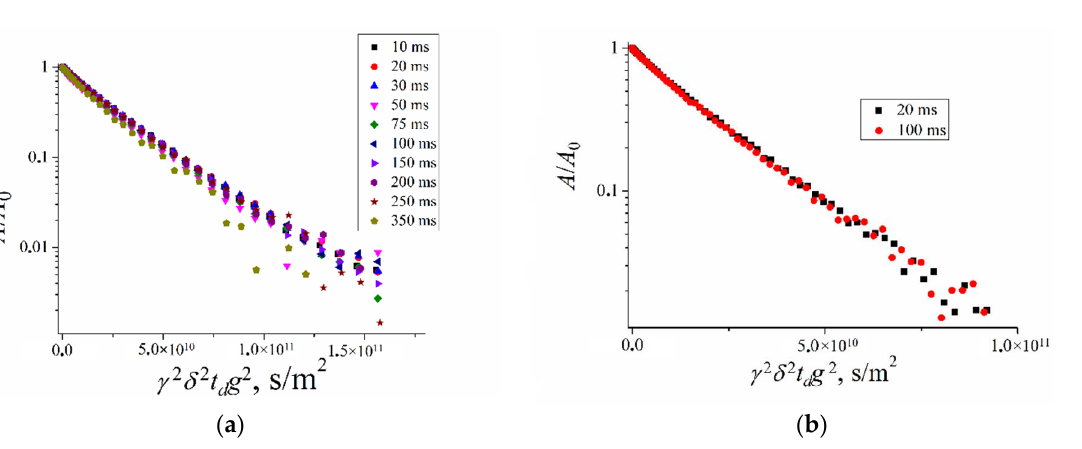
Figure 8. 10 Diffusion decays of 1 H and 19 F nuclei of compound X at different diffusion times t d : ( a )— 1 H nuclei; ( b )– 19 F nuclei. The values of t d show in insertions. The aqueous solution concentration is 50